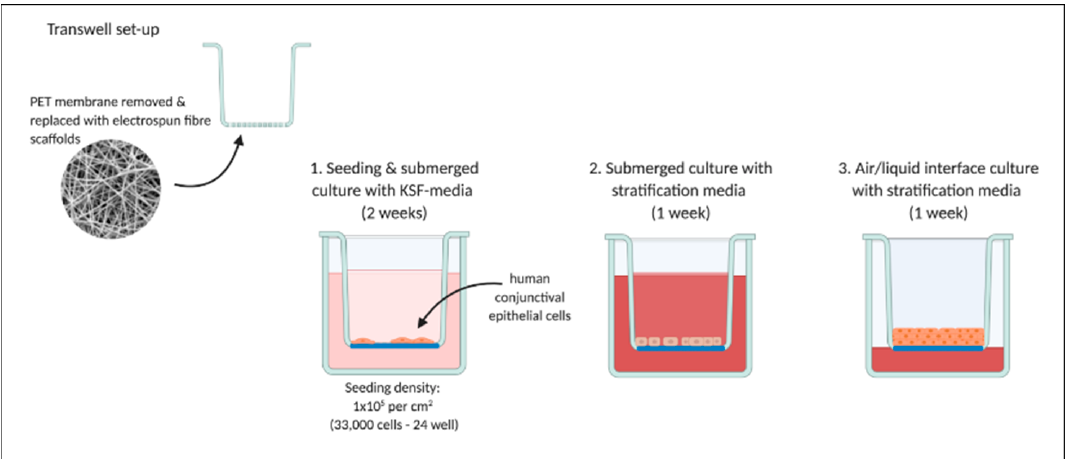
Figure 2. Experimental set-up for in vitro culture of human conjunctival epithelial cells demonstrating preparation of transwells with removal of polyester (PET) membrane and replacement with electrospun scaffolds. Cells were seeded and cultured fully submerged for two weeks with keratinocyte serum free media (KSF-media), followed by one week with stratification media and a further week at the air/liquid interface with media received on the cells’ basal side. Created with BioRen- der.com.